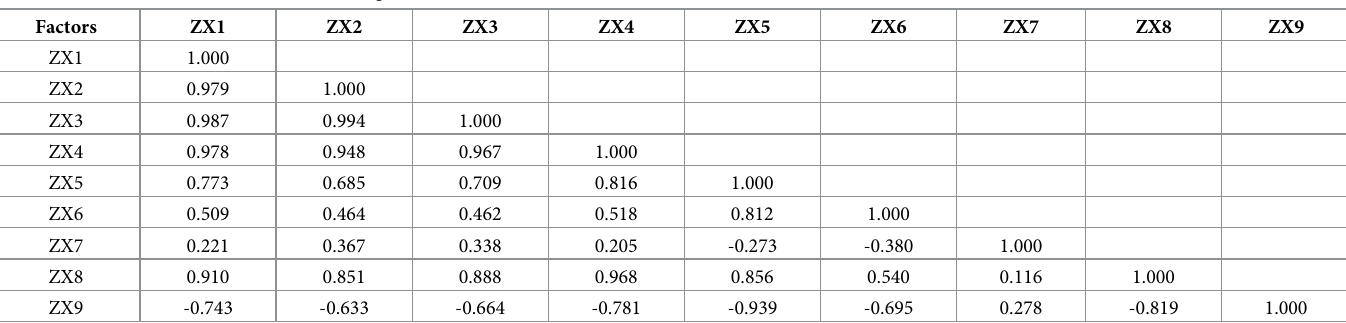
the SPSS analysis results. On this basis, a comprehensive score equation including all factors affecting farmland change was obtained, as shown in Eq (8), according to the contribution rate of two principal components to farmland change.